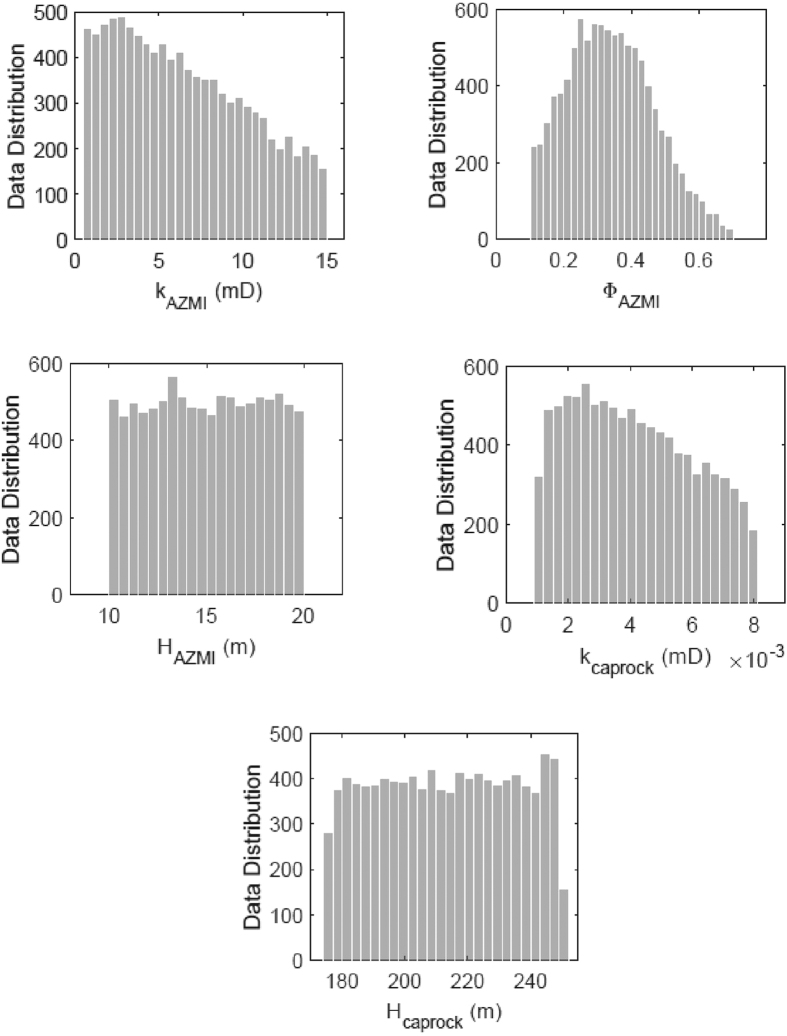
Distribution of AZMI permeability (kAZMI), AZMI porosity (ΦAZMI), thickness of AZMI (HAZMI), caprock permeability (kcaprock) and caprock thickness (Hcaprock) for aPC uncertainty analysis.